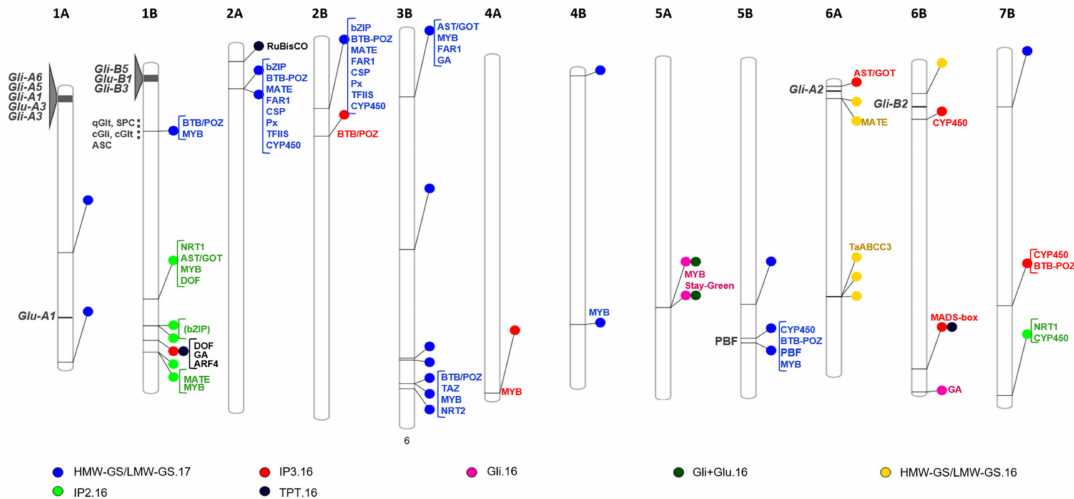
Figure 5. PhenoGram used to plot association results for gluten protein composition traits and immunogenic and toxic epitopes plot along 12 durum wheat chromosomes (chr. 3A and chr. 7A were omitted as no significant MTAs were found). Lines drawn on the chromosomes correspond to the physical location [20] of each MTA, and are connected to colored circles representing the phenotype(s) associated with the corresponding SNP. Genes / QTLs known in literature were reported on the left of each chromosome. Significant candidate genes were reported on the right. Gli = gliadins; Glu = glutenins; NRT1 = nitrate transporter; AST / GOT = aspartate aminotransferase; GAs = Gibberellin-regulated family protein; bZIP = basic leucine zipper; DOF = DNA binding with one finger; PBF = prolamin binding factor; ARF 4 = Auxin response factor 4; RuBisCO = ribulose-1 5-bisphosphate carboxylase oxygenase protein; CSP = cold shock protein, Px = peroxidase; CYP450 = Cytochrome P450 superfamily; NRT2 = high a ffi nity nitrate transporter; TFIIS = Transcription elongation factor S-II; MYB = TaABCC3 = ABC